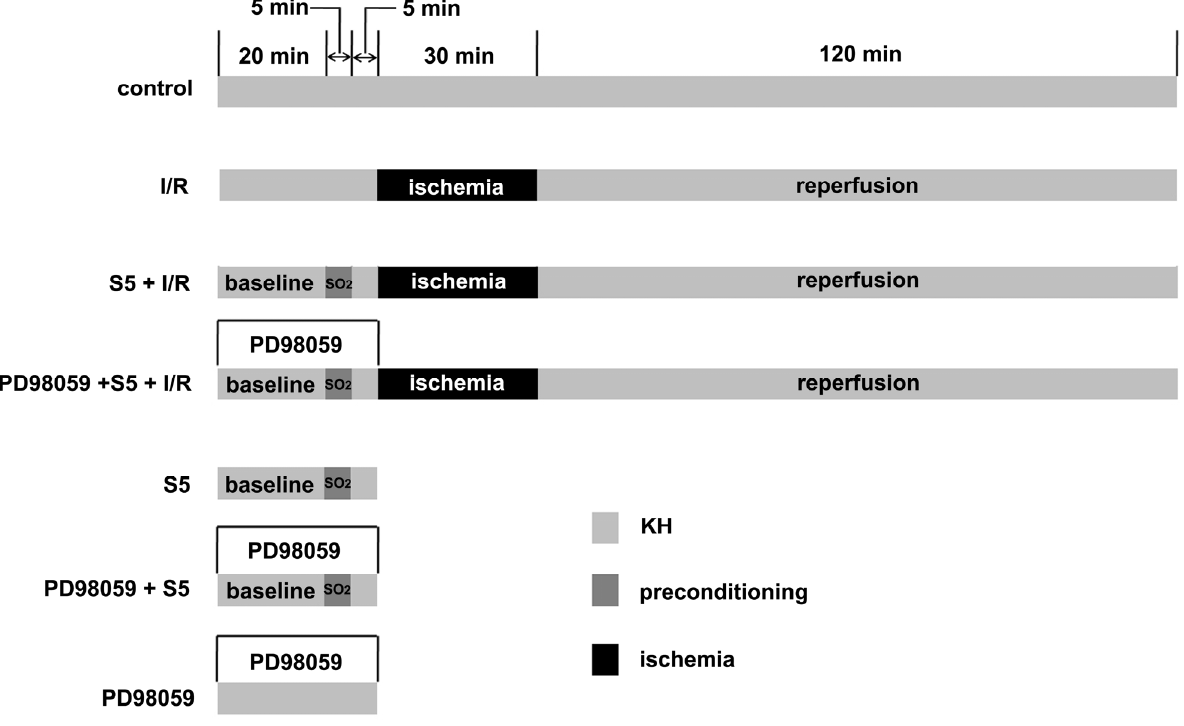
derivatives for 2